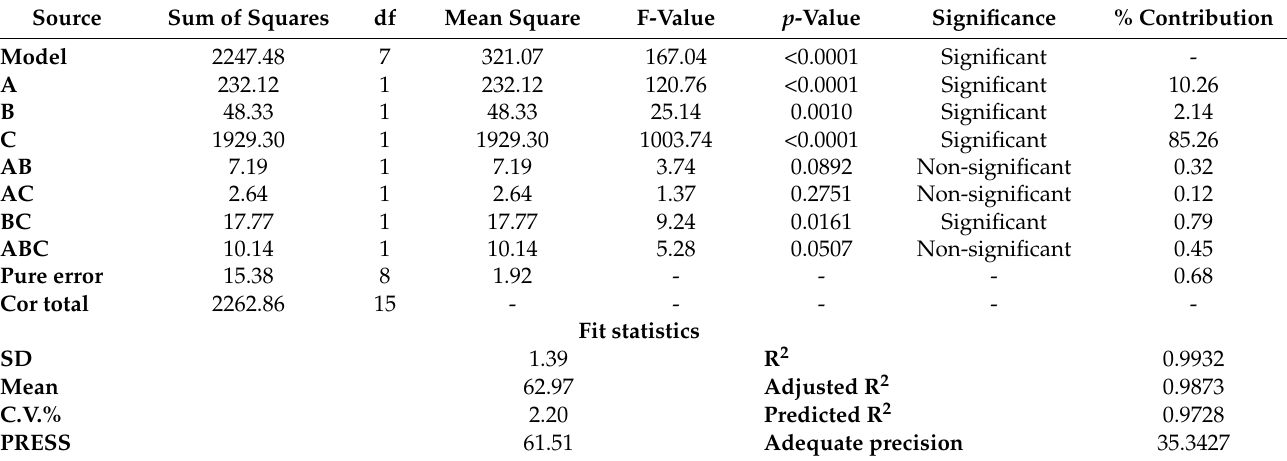
Table 6. Results of ANOVA statistical analysis of Y 2